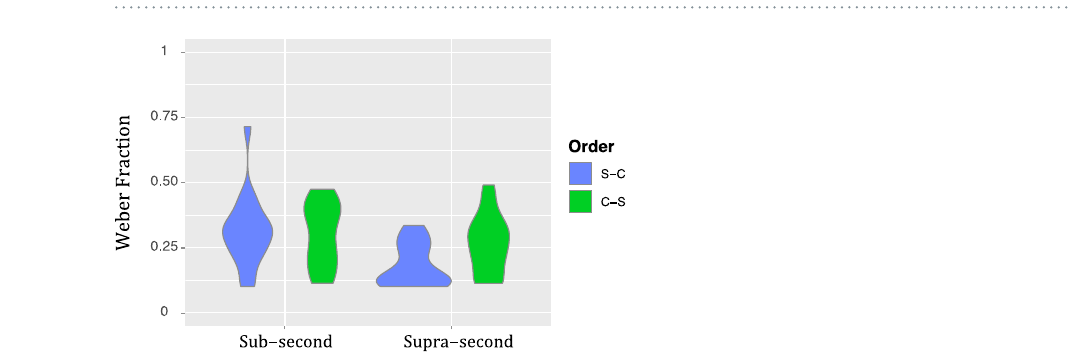
= 0.90) and a non-significant interaction G